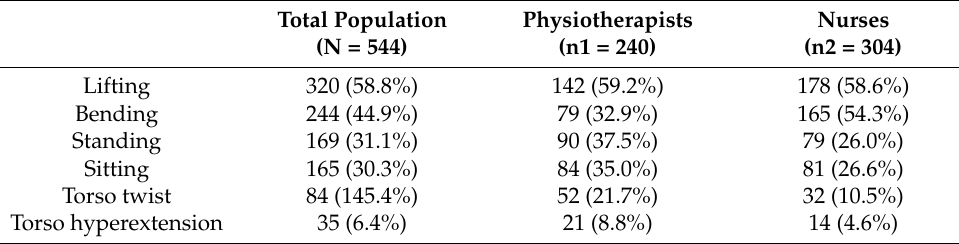
Table 4. Activities triggering